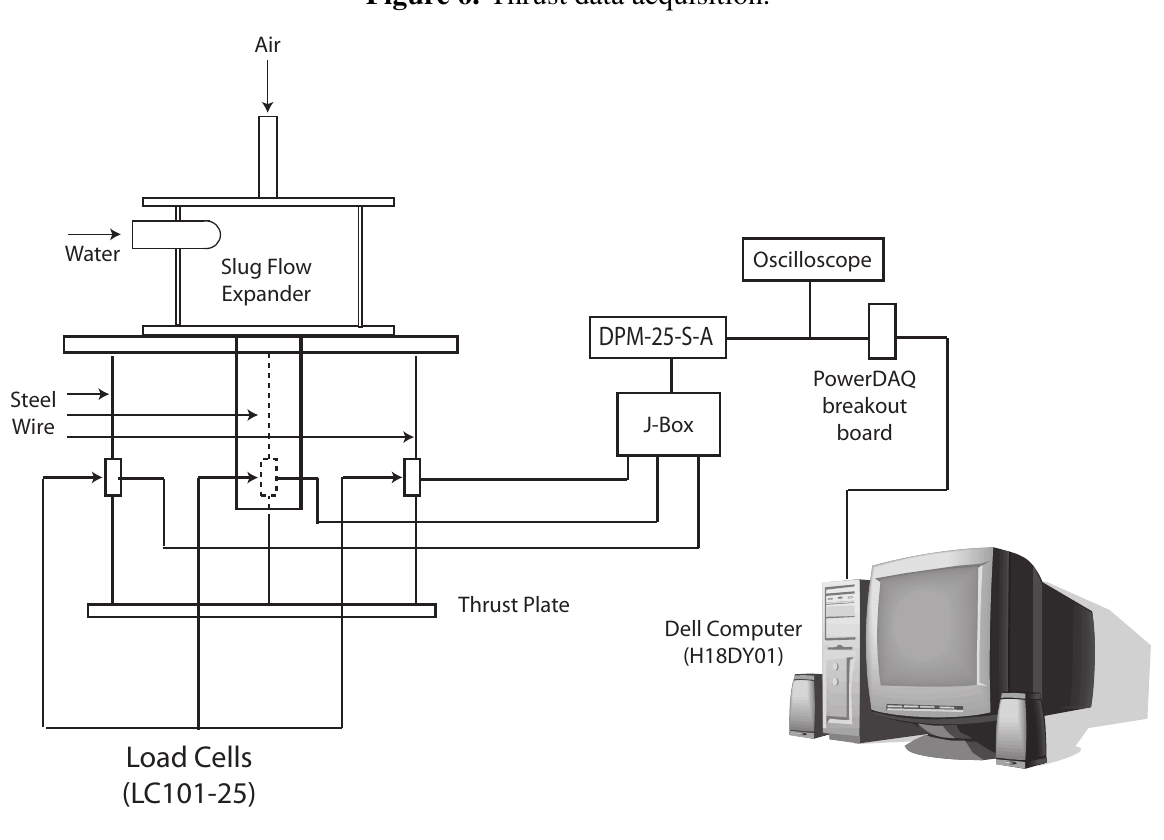
Figure 6. Thrust data